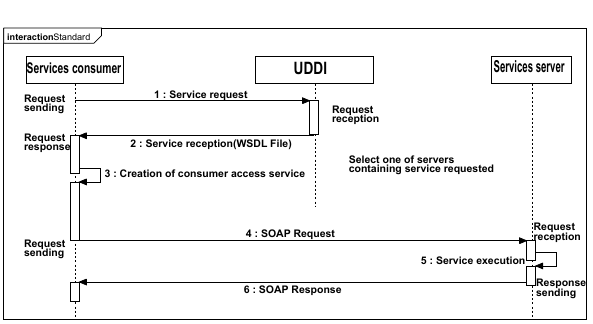
Figure 1. Standard Web services access via SOAP, UDDI,